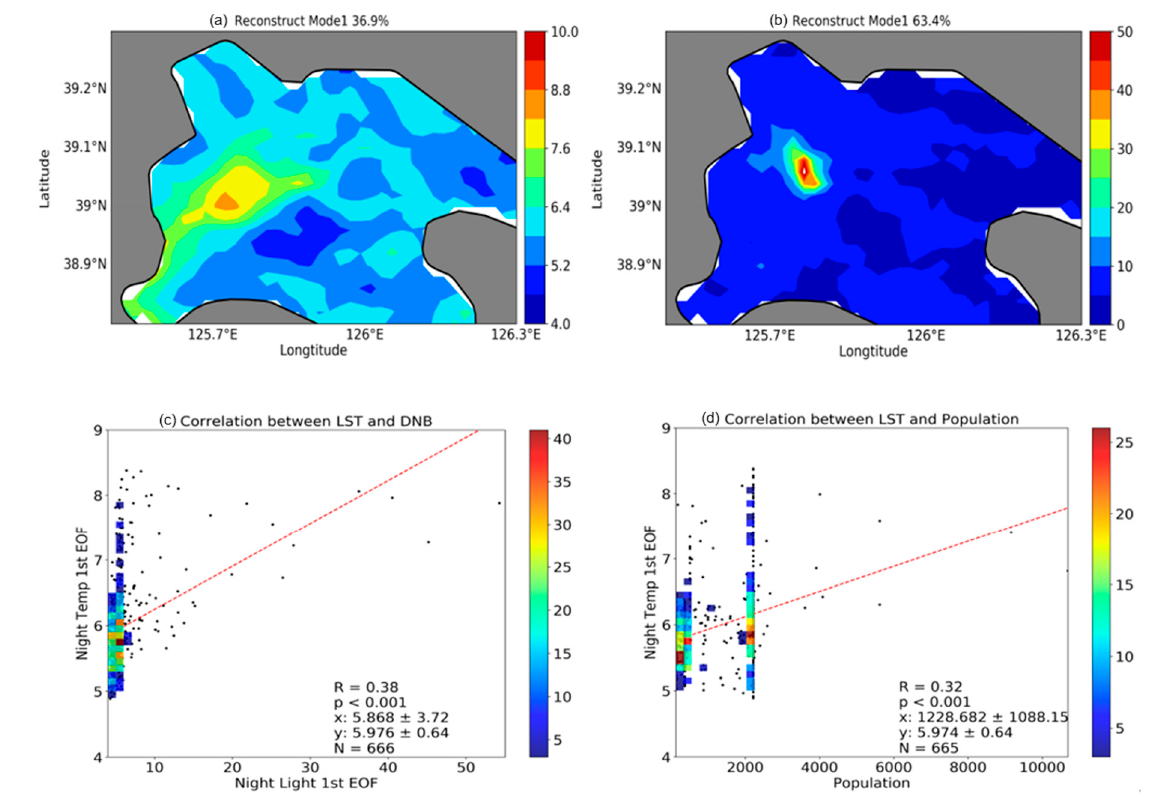
Figure 11. The reconstructed mode 1 LST and DNB datasets and the correlation between them in Pyongyang: ( a ) the spatial distribution of the reconstruct mode 1 LST and ( b ) DNB datasets; ( c ) the correlation between reconstructed LST and DNB datasets using mode 1; ( d ) is the correlation between reconstructed LST and original population data.